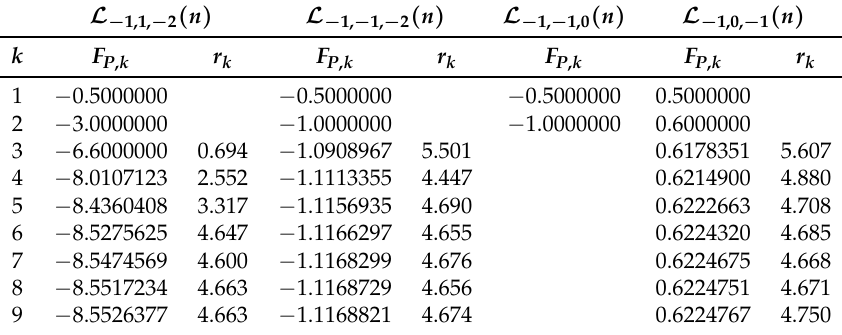
Table 1. Numerically computed parameter values F P , k for which a pitchfork bifurcation takes place in the system L α , β , γ ( n ) with dimension n = 2 k for k = 1, · · · ,9. Note that L − 1,1, − 2 ( n ) is the original Lorenz-96 model. In addition, the ratio r k = ( F P , k − 1 − F P , k − 2 ) / ( F P , k − F P , k − 1 ) is listed, except for the system L − 1, − 1,0 ( n ) , in which case the second pitchfork bifurcation is subcritical and the cascade terminates. See the main text for